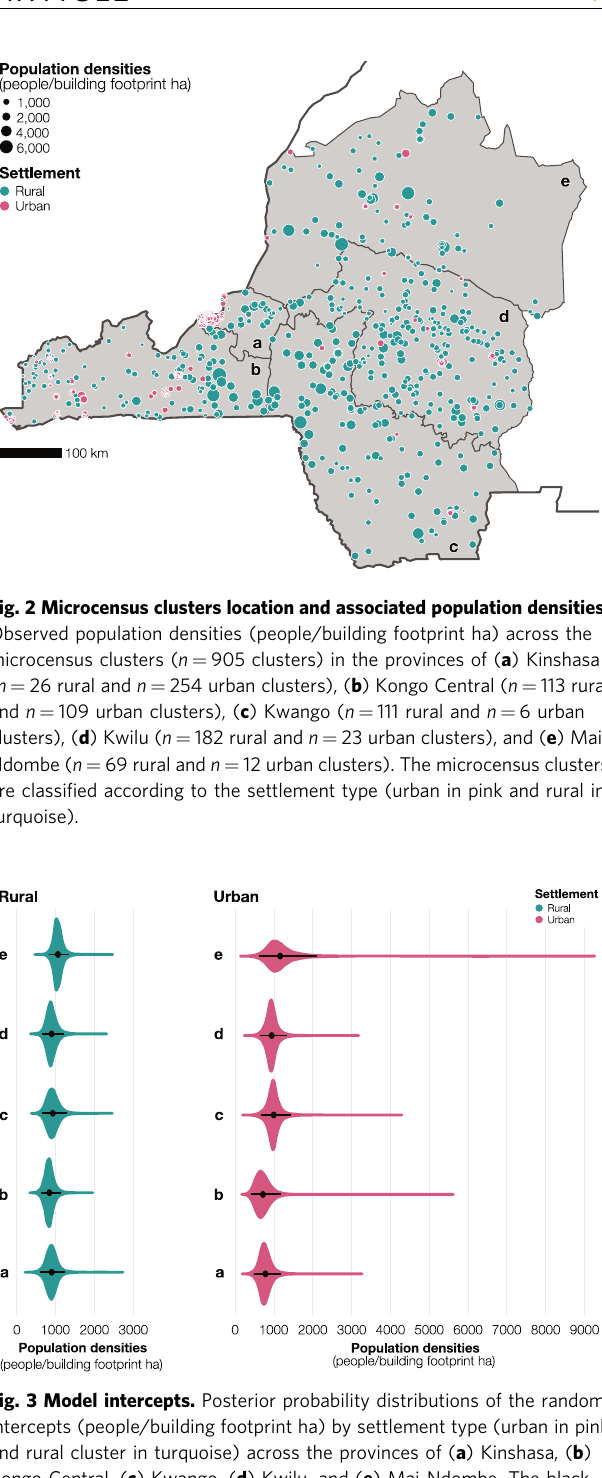
Figure 6 visually contrasts the observed population totals (people) and densities (people/ building footprint ha) versus in- sample and out-of-sample posterior predictions according to settlement type. The fi gure con fi rms a very good model fi t for population totals, which were generally in line with the observed